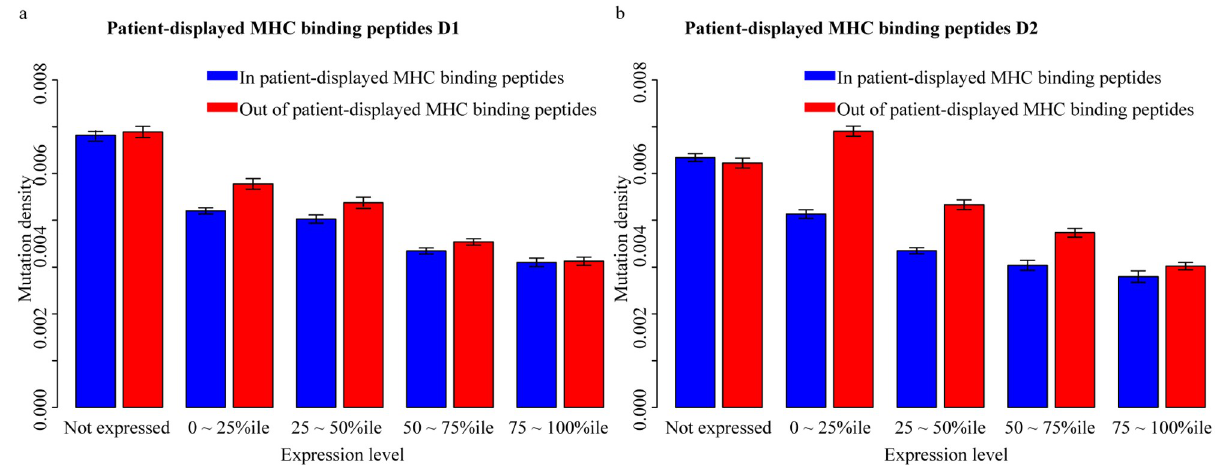
Fig 4. MHC-display-dependent mutation densities for genes with different expression levels, considering the number of displaying HLA alleles. Average mutation density in peptides predicted to be displayed by one or two of the 12 common HLA-A or HLA-B allele types. A. Mutation density in peptides predicted to be displayed in patients by only one HLA allele. B. Mutation density in peptides predicted to be displayed in patients with two displaying HLA alleles.